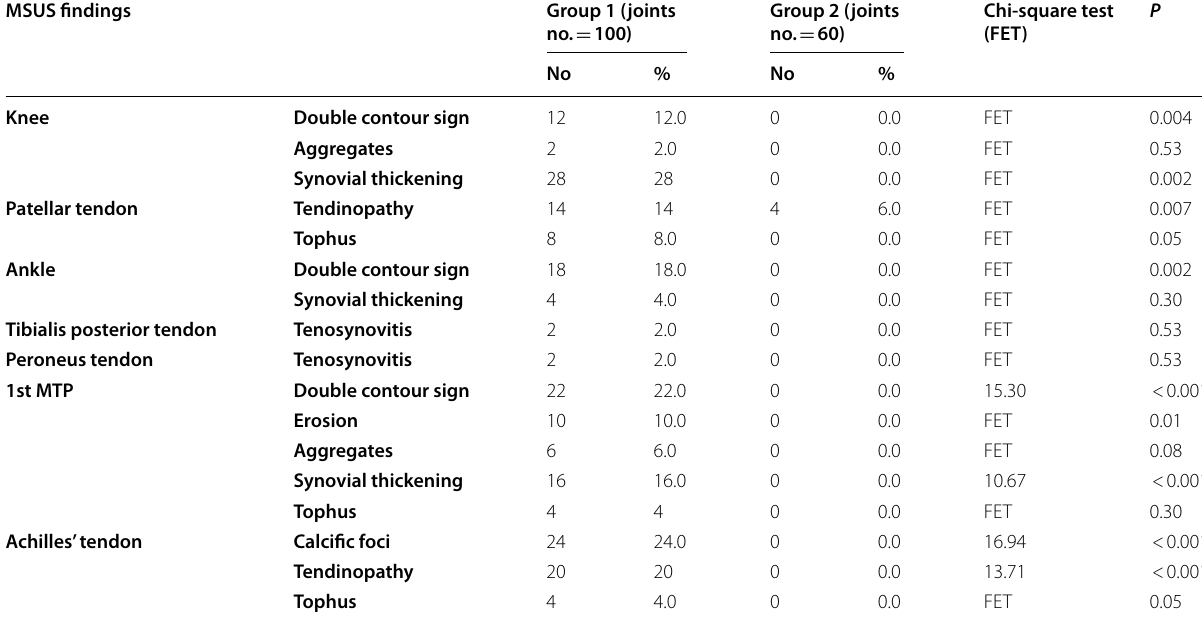
Table 1 MSUS findings of the studied groups MSUS findings